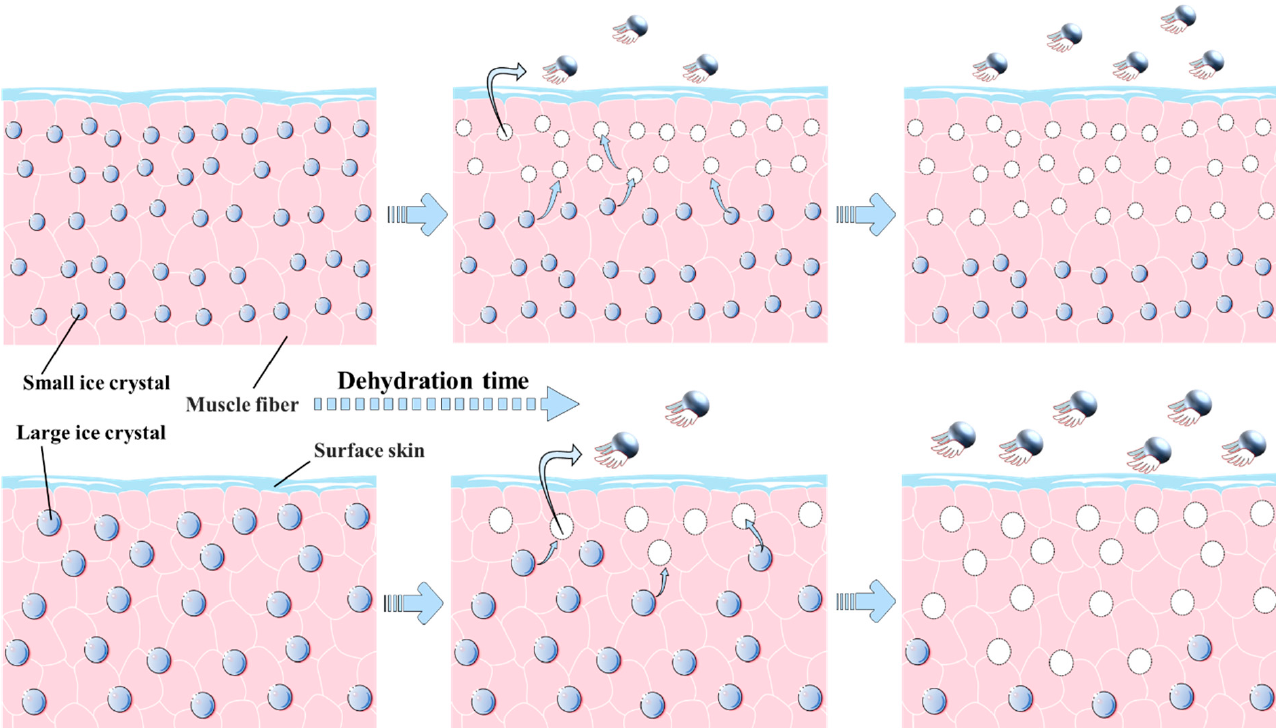
Figure 1. Effect of dehydration treatment on weight loss ( A ) and water content ( B ) of large yellow croaker. Different lowercase letters in the same index indicate significant differences ( p < 0.05). The water content of the fresh sample (CK) was 83 ± 0.63%.